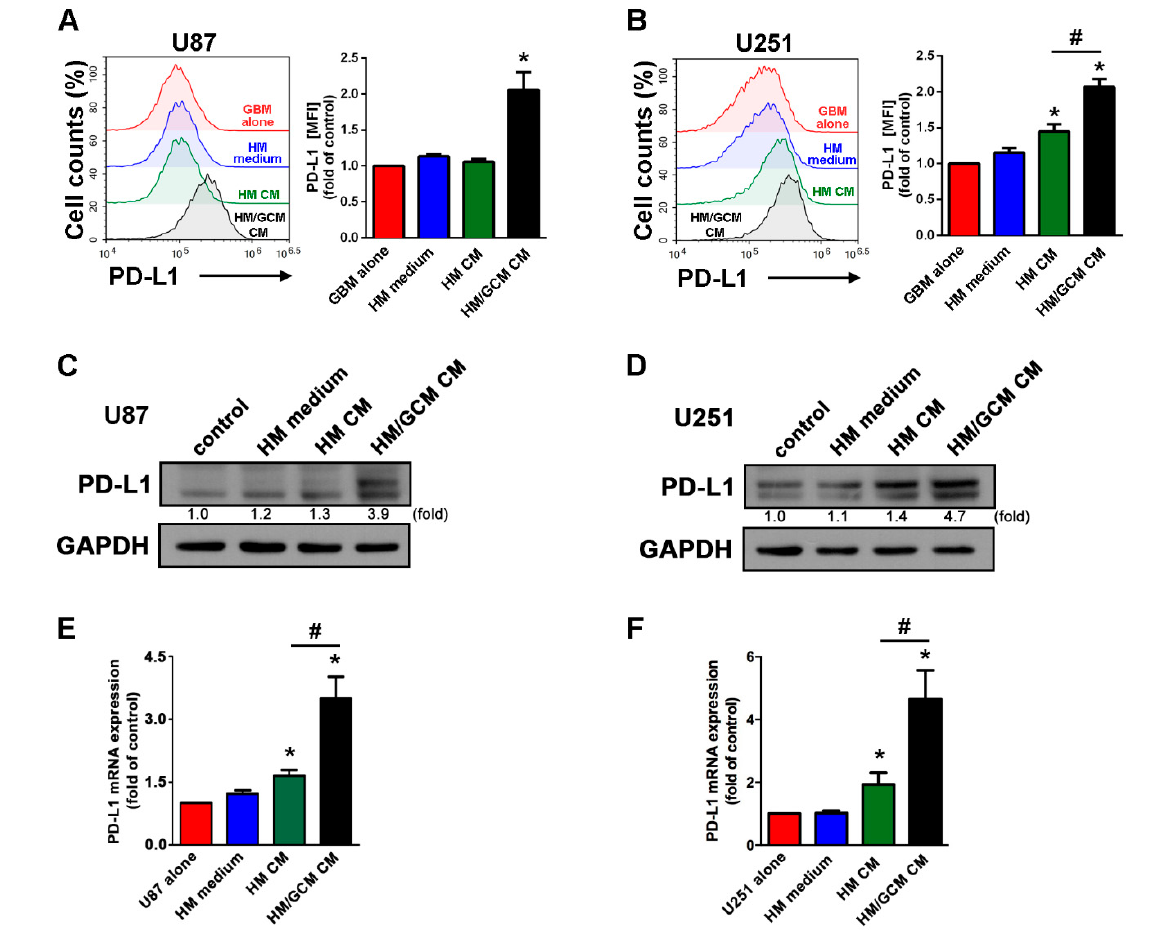
Figure 4. GBM primed macrophage potentiates PD-L1 expression in GBMs. Human U87 ( A , C , E ) and U251 ( B , D , F ) GBM were incubated with GBM cultured medium, THP-1 cultured medium, HM CM, or HM/GCM CM for 48 h. PD-L1 expression was determined by flow cytometry analysis ( A , B ), Western blot ( C and D ), and real time-PCR ( E , F ). * p < 0.05 compared with GBM alone group. # p < 0.05 compared with HM CM group. ( n = 3–4).